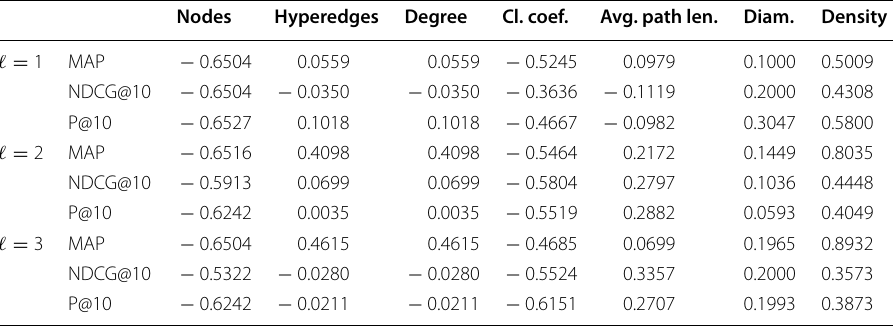
Table 8 Spearman’s ρ between evaluation metrics and structural features